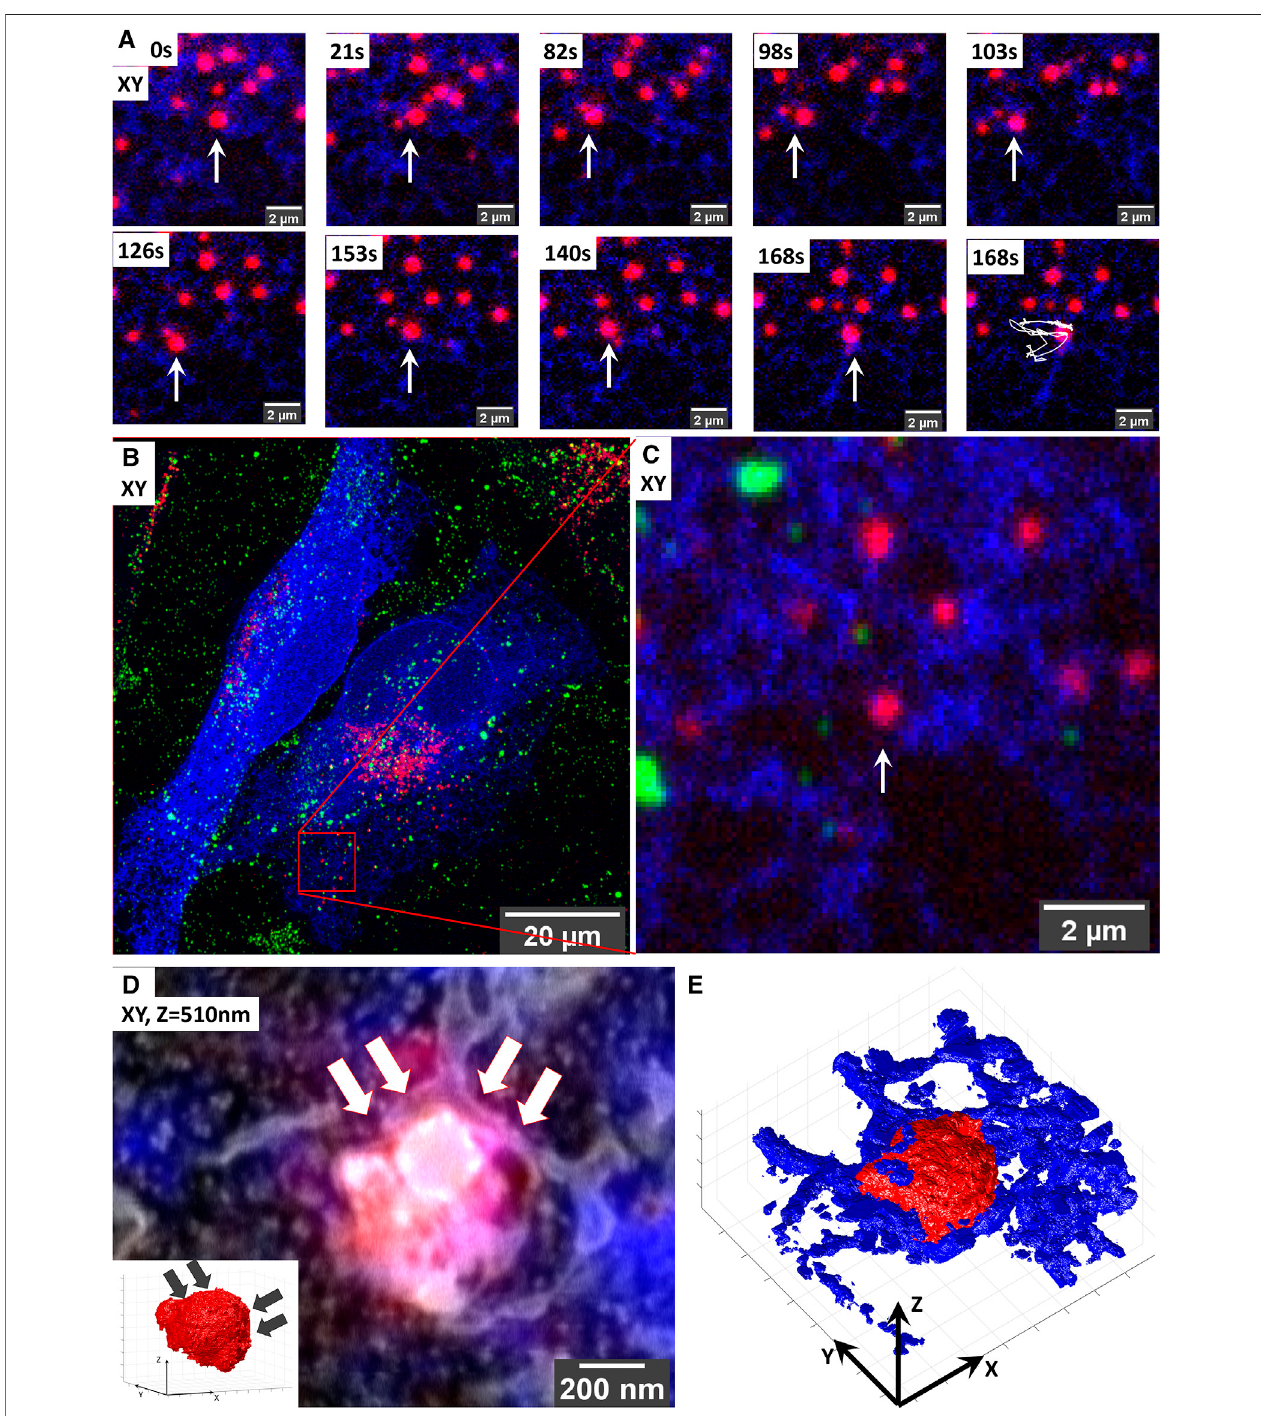
FIGURE 4 | Targeted volume-CLEM of ER-lysosome contact sites implicates ER in lysosomal motility. (A) Live-cell imaging of lysosome dynamics in relation to ER contacts.LysosomesarestainedwithSiRLyso(red)andERwithmEmerald-Sec61 β (blue).Arrowpointstothelysosometargetedforimaging.At168s,thelastimageof the time-lapse panel, the dragon tail shows that the lysosome mainly follows the ER tubules and that ER contact on its right side con fi nes its movement. (B) Maximum intensity projection of the CLSM stack recorded after in situ fi xation; note the endocytic fi ducial markers visible as green. (B) Image of entire cell indicating the imaged ROI. (C) Zoom-in to the ROI. (D) Overlay of 3D CLSM data from the fi xed cell and the 3D FIB.SEM data showing the single targeted lysosome traced back after resin embedding using iCLSM/FIB.SEM. The small ROIincludes the lysosome-ER contacts. Inset shows that thecurvature ofthe lysosome surface is altered on the site ofdenseERinteractionindicatedwitharrows. (E) Segmentation ofthelysosomes(red)andER(blue)inthestackhighlightsthedensepresence ofERontherightsideof the lysosome.